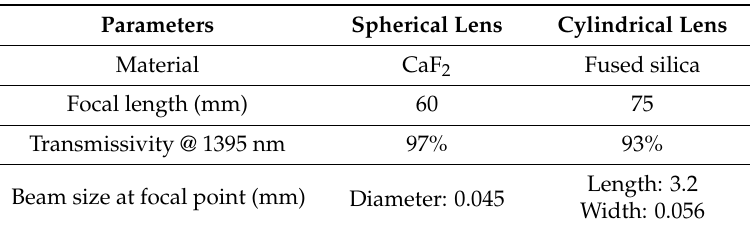
Table 2. Lens parameters and beam characteristics.